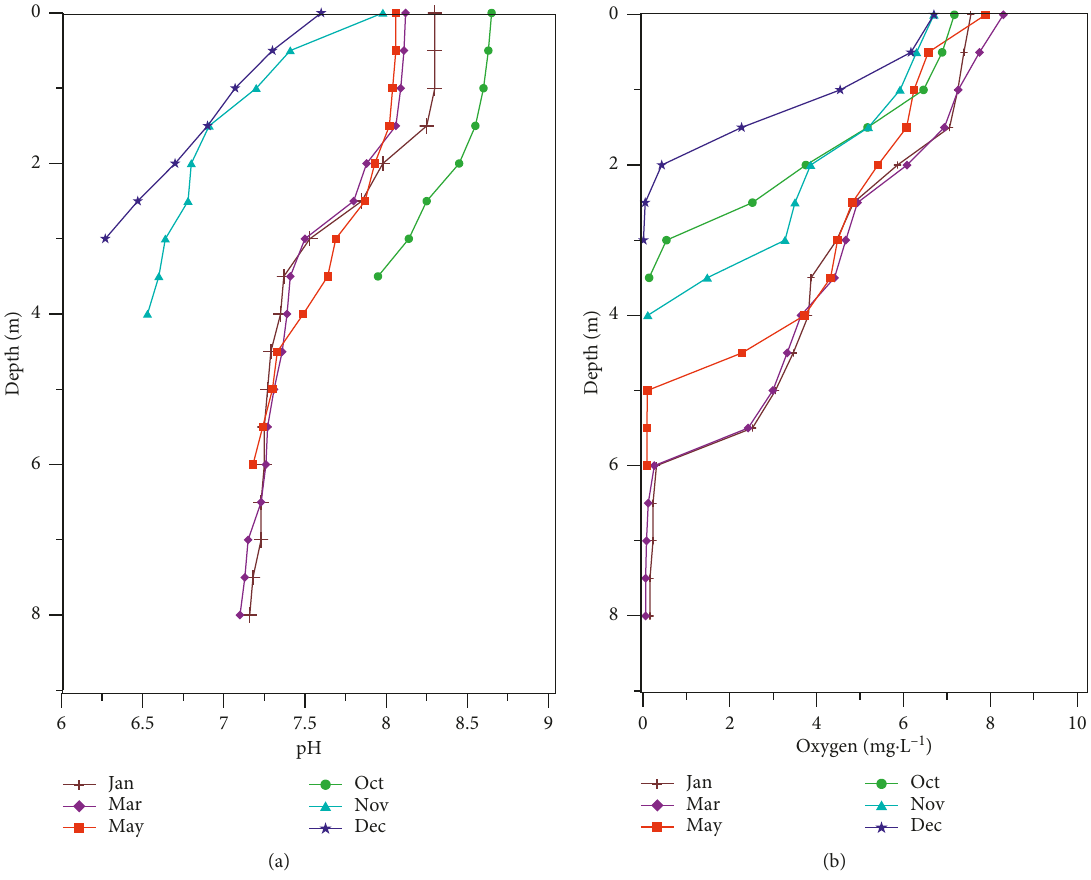
Figure 4: Vertical profiles of pH and